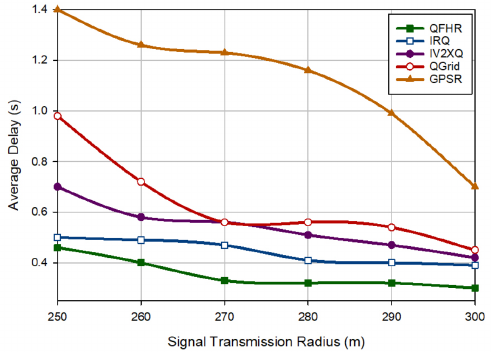
Figure 13. Average delay in different routing approaches according to